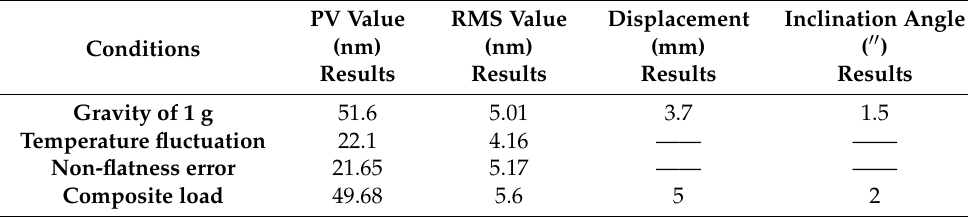
Table 2. Simulation analysis results.